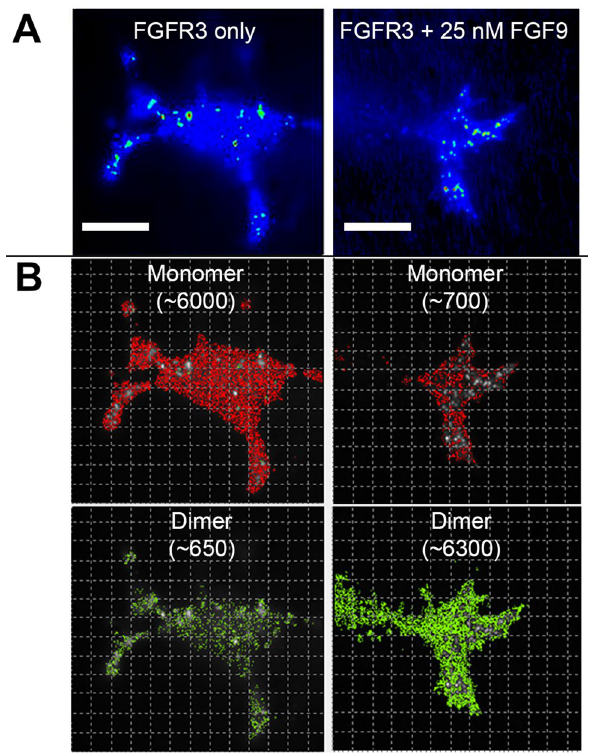
Figure 2. Depiction of intensity and molecular brightness images. (A) (Intensity) Typical single cell intensity images are shown for cells that have not been exposed to FGF9 ligand (left column) and cells exposed to 25 nM FGF9 ligand (right column). Scale bar is 15 microns. ( B) (Molecular brightness) The normalized average molecular brightness images for each cell indicate monomer (red) and dimer (green) numbers and distribution throughout the cell with corresponding pixel counts, which is the number of pixels that contain dimer or monomer,